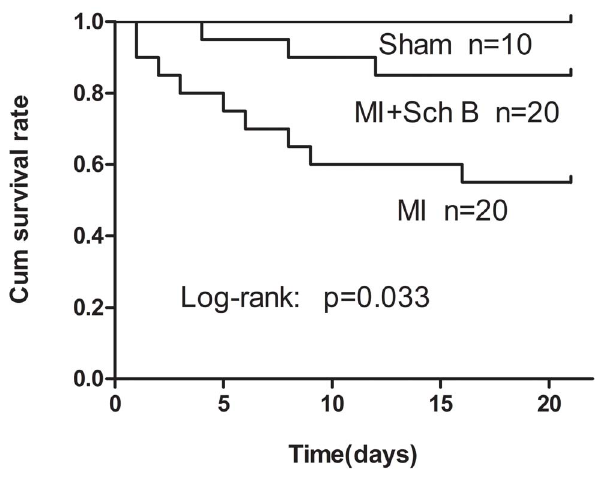
Figure 1. Survival rate at 3 weeks after myocardial infarction (MI). Kaplan-Meier analysis showed significantly lower mortality in Schisandrin B (Sch B) treated mice after MI than in untreated MI mice (log-rank : P